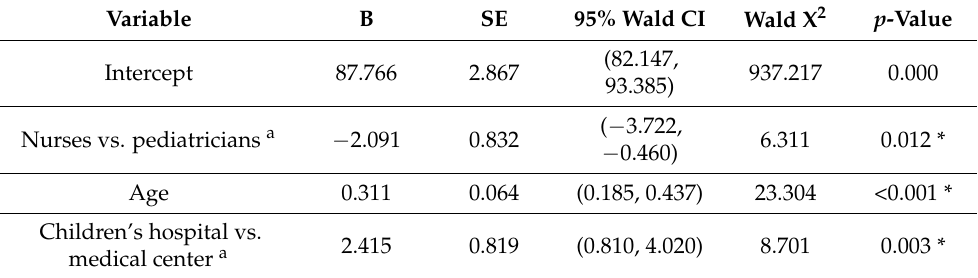
Table 3. Factors impacting knowledge scores using multiple linear regression (N =